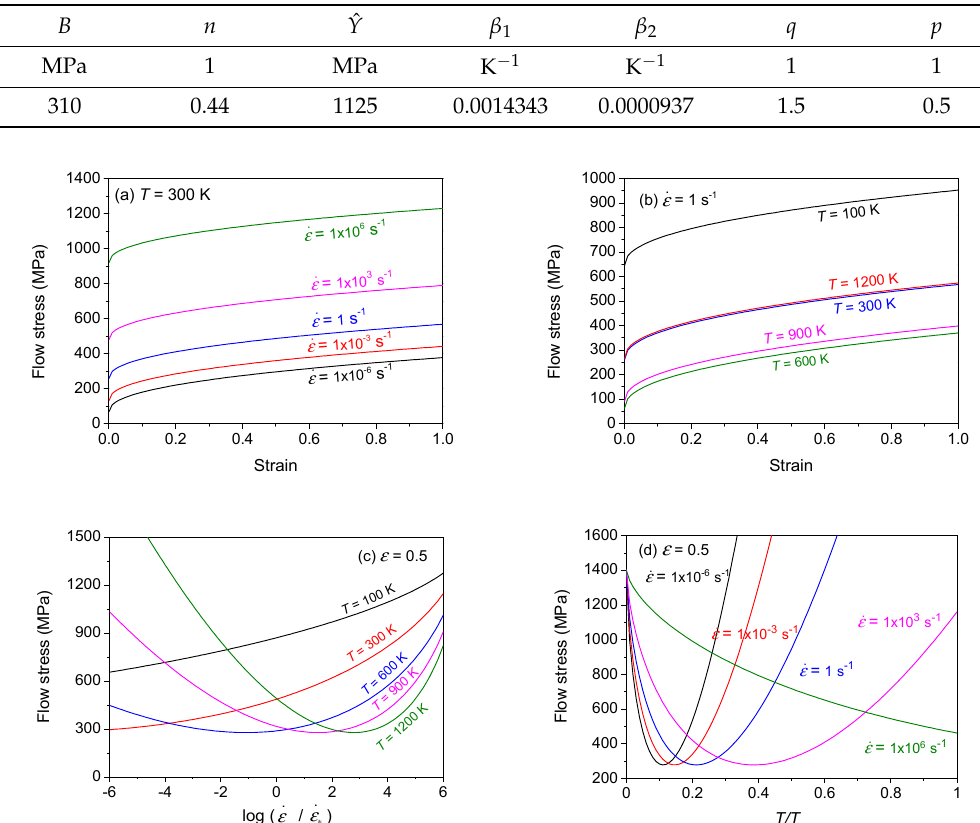
Table 9. Parameters of the VA model for tantalum (